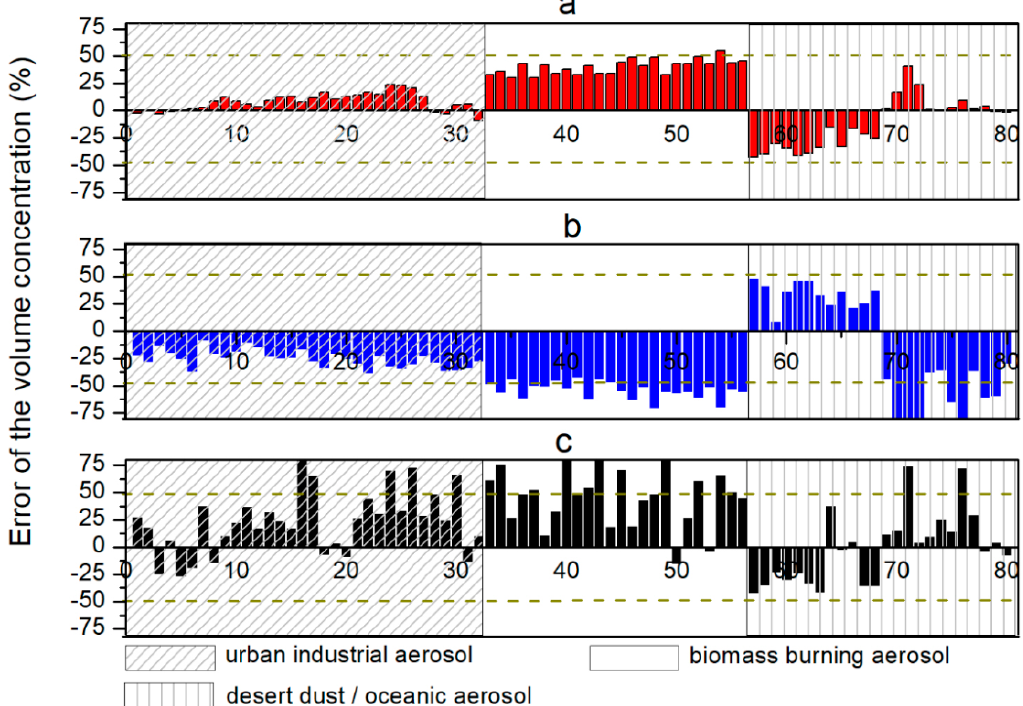
Figure 5. Inversion error of the volume concentration. ( a ) error of the volume concentration from the error-free data (red columns); ( b ) error of the volume concentration from the data with 10% systematic error (blue columns); ( c ) error of the volume concentration from the data with 15% random error (black columns).